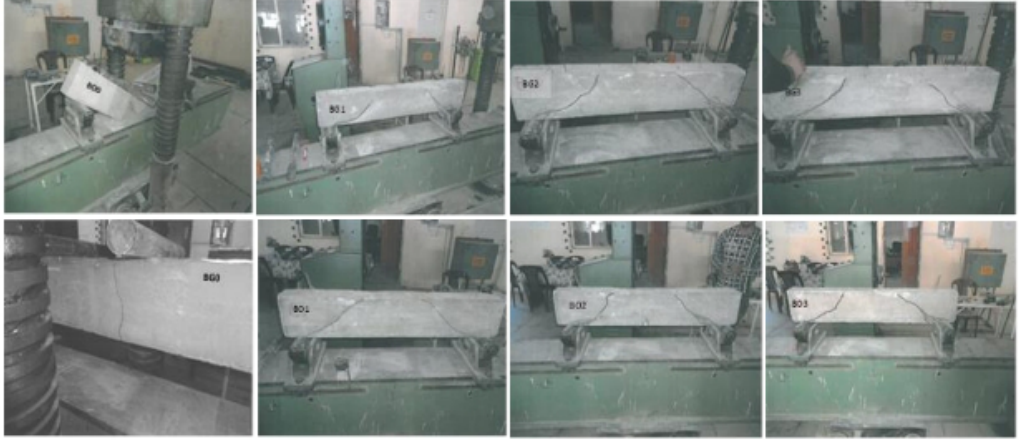
Fig. 13. Failure Patterns of Tested